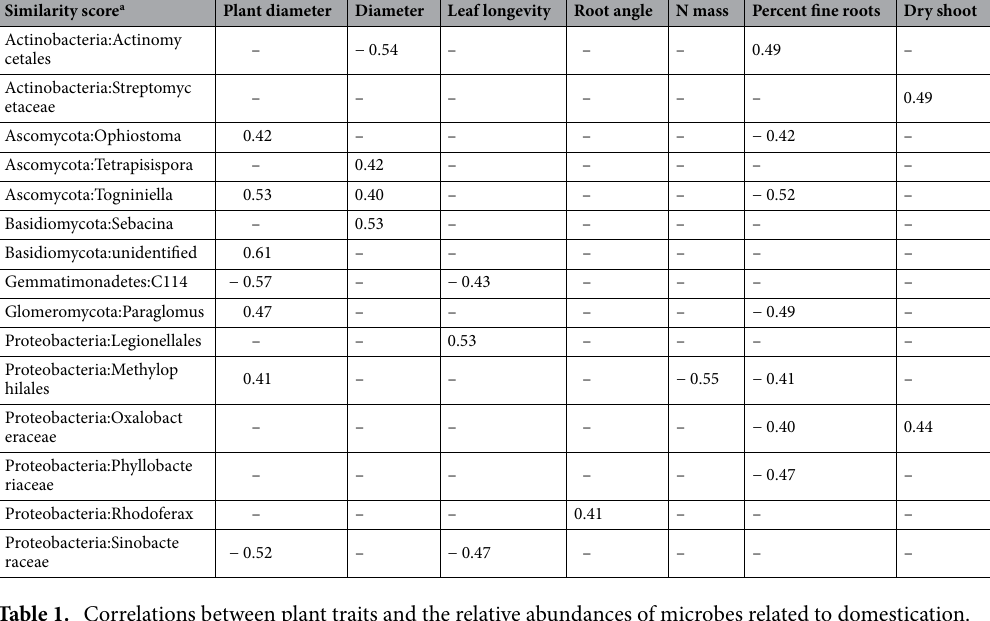
Table 1. Correlations between plant traits and the relative abundances of microbes related to domestication. a Note that similarity scores in DIABLO are analogous to Pearson’s correlation